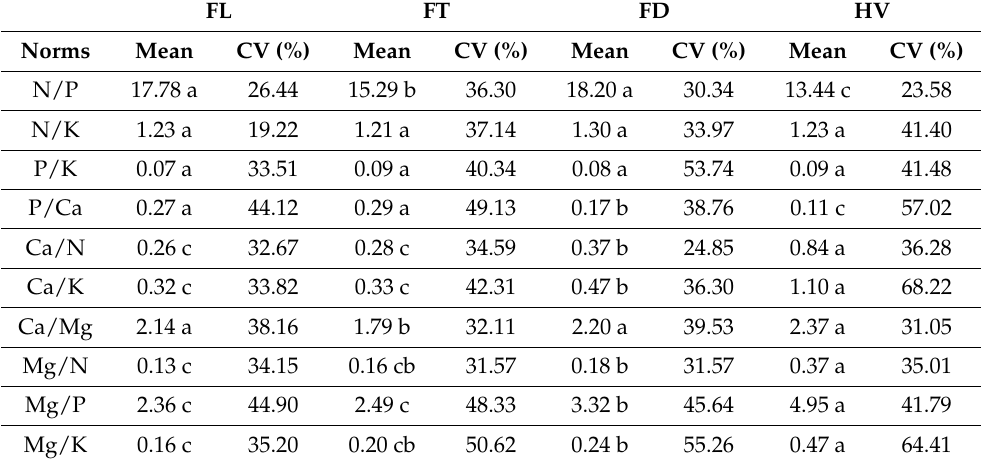
Table 2. Diagnosis and recommendation integrated system norms in different phenological stages of pepper crop. Means with different letters in the same row indicate significant differences be- tween the different phenological stages. Flowering (FL), fruiting (FT), fruit development (FD), and harvesting